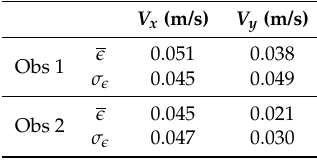
Table 1. Simulated scenario 1—Errors in velocities